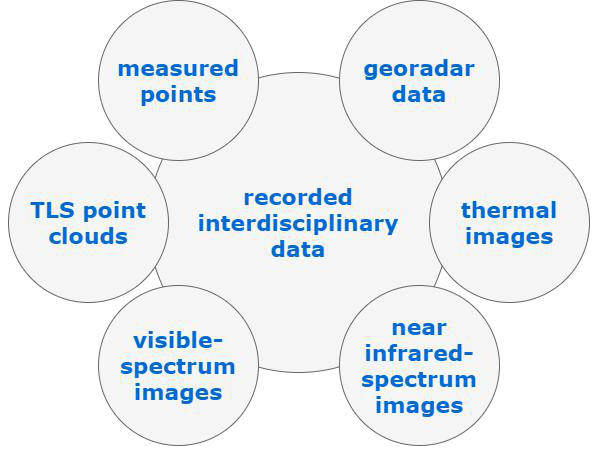
Figure 3. Scheme of recorded data.